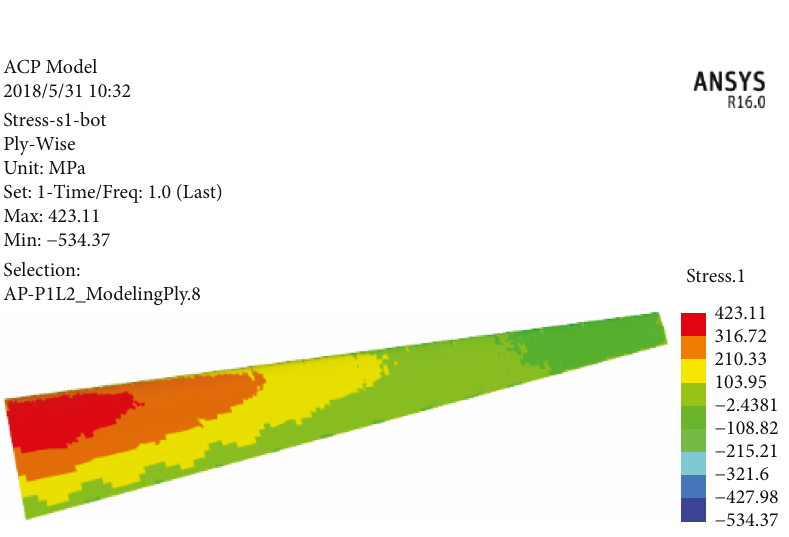
Figure 43: Stress cloud diagram of the lower wing with the layer ratio being 10%/10%/80%.